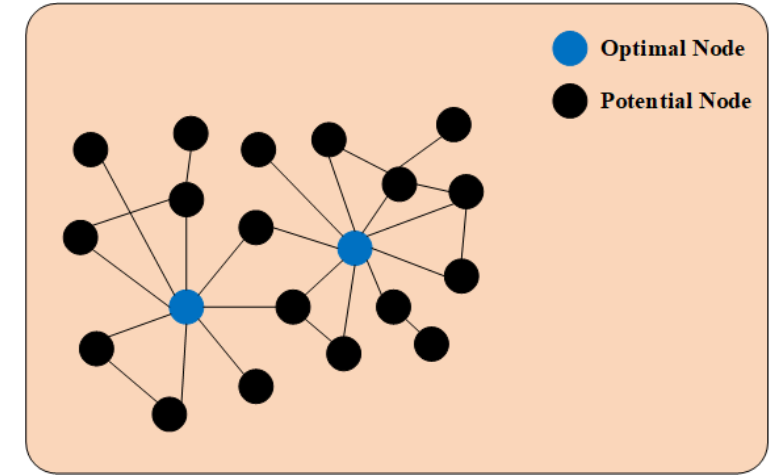
Figure 3. The SN